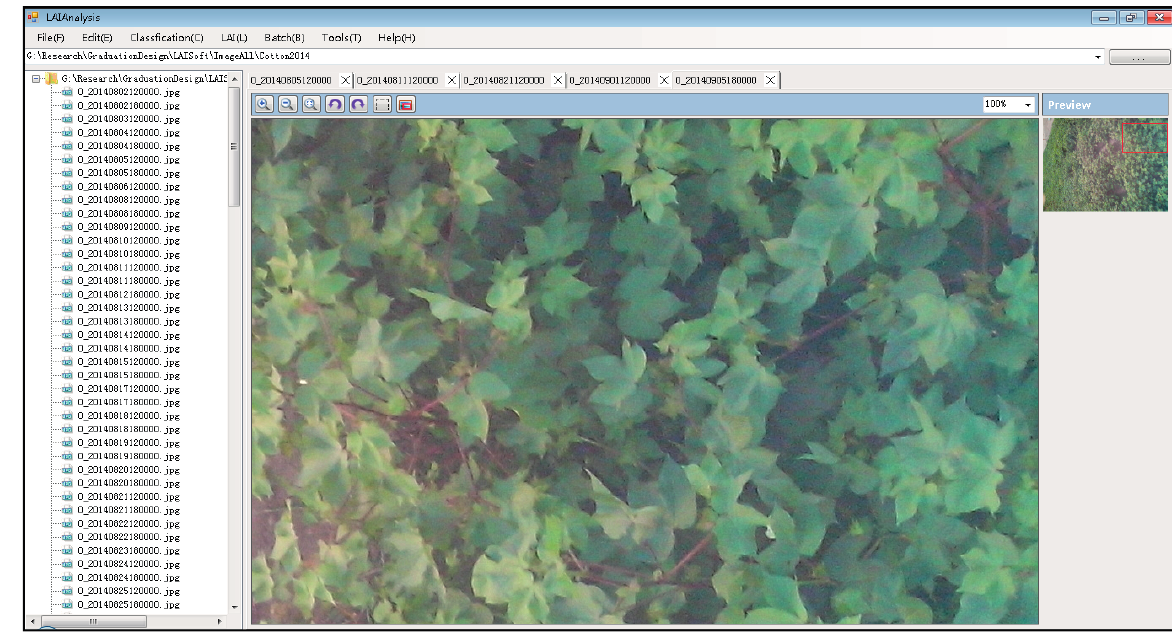
Figure 10. Image